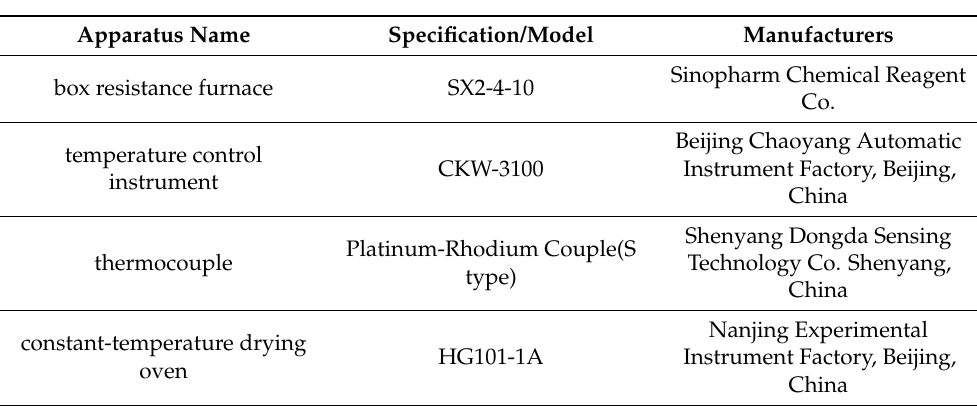
Table 2. Experiment